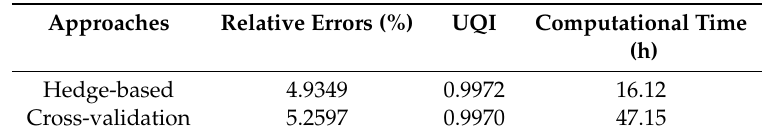
Table 3. Relative errors, UQI and computational time of image reconstruction results from two hyper-parameter selection approaches. (Boldface numbers indicate the best result).